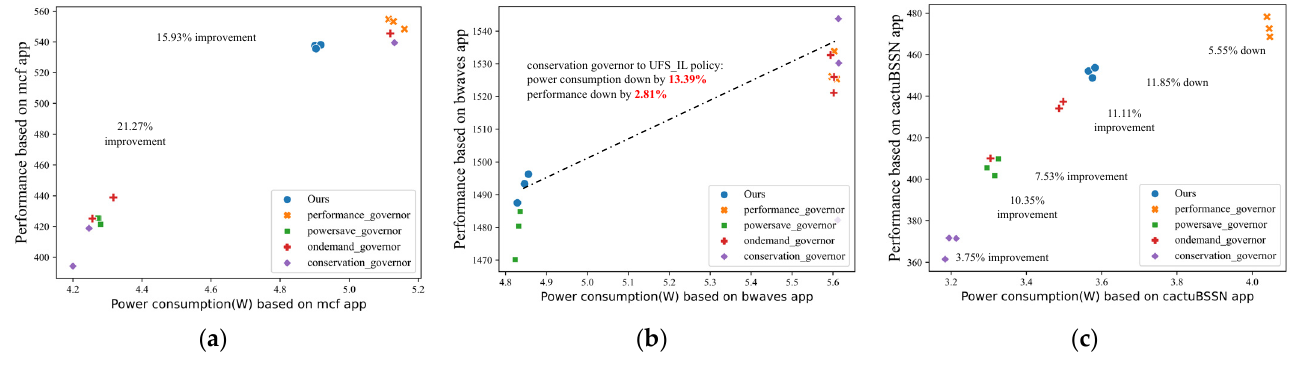
Figure 6. Performance and power consumption data distribution for different benchmark apps with different governors and the UFS_IL policy: ( a ) mcf app; ( b ) bwaves app; ( c ) cactuBSSN app.